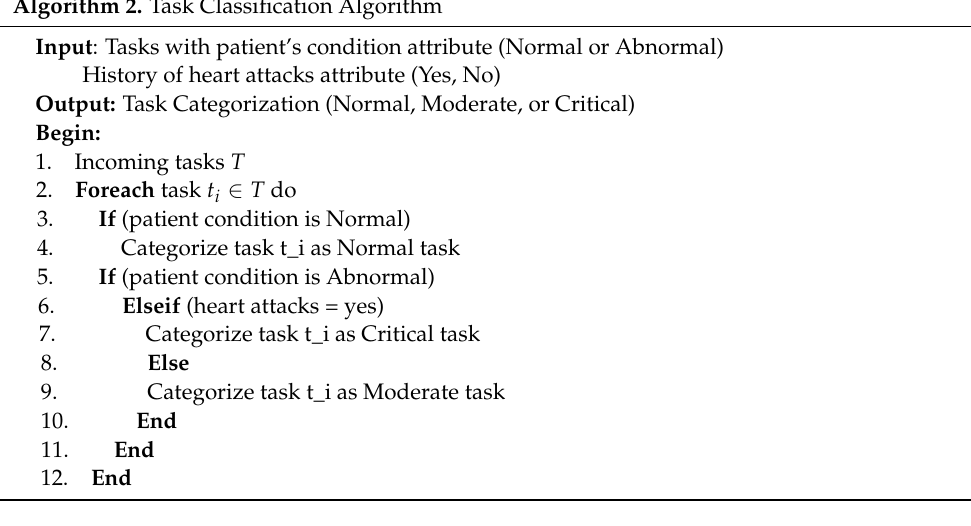
Algorithm 2. Task Classification Algorithm